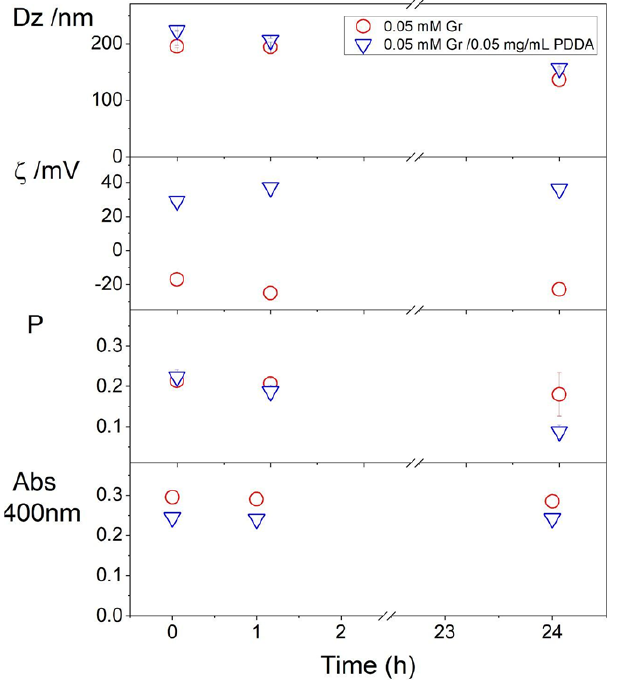
Figure 4. Colloidal stability of gramicidin (Gr) nanoparticles (NPs) in the absence or presence of poly (diallyldimethyl ammonium chloride) (PDDA). Mean z-average diameter (Dz), zeta potential ( ζ ), polydispersity (P), and turbidity at 400 nm (Abs 400 nm) of gramicidin (Gr) nanoparticles in water or in 0.05 mg/mL PDDA as a function of time.